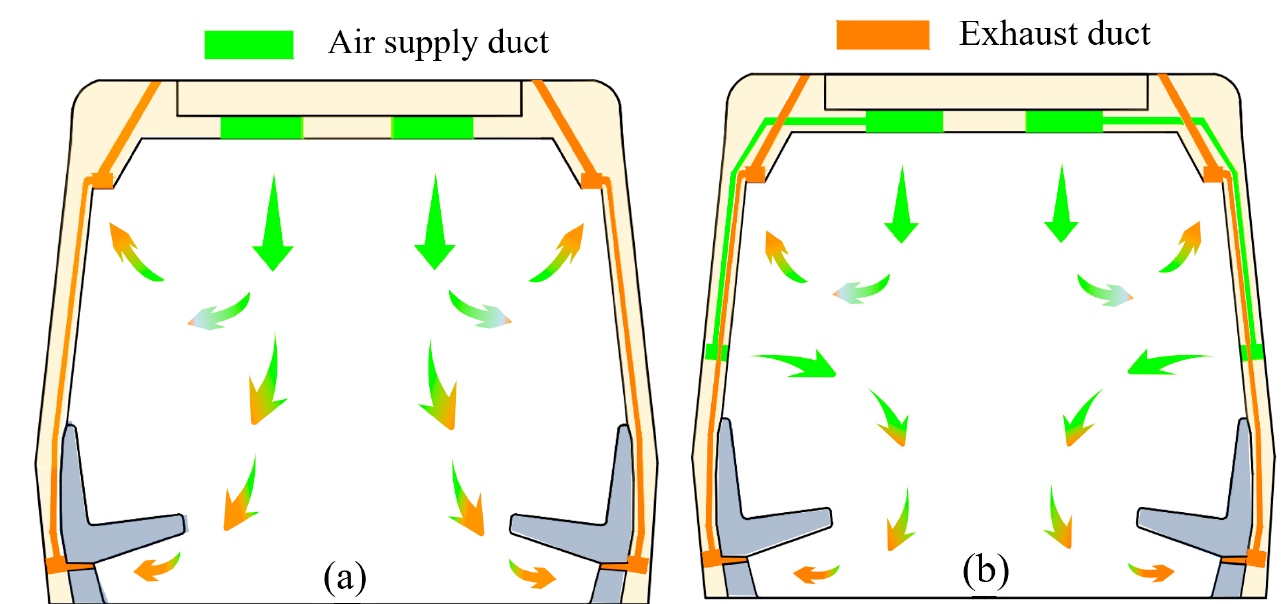
Figure 1. Schematic diagram of airflow organization in subway cars equipped with ( a ) conventional ventilation (CV) and ( b ) stratum ventilation (SV).